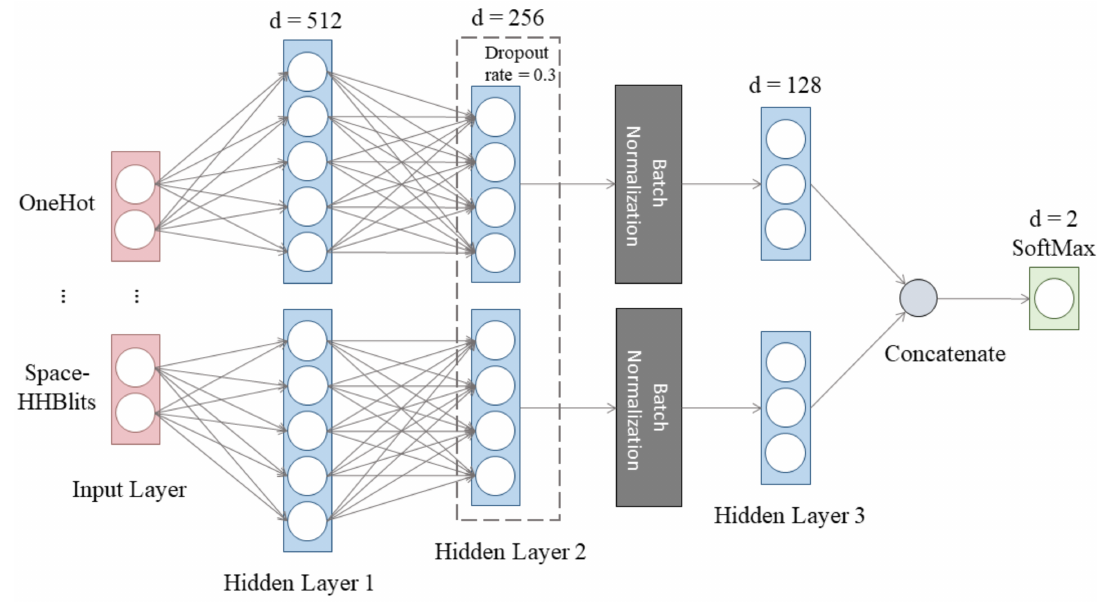
Figure 2. The structure of the MLP